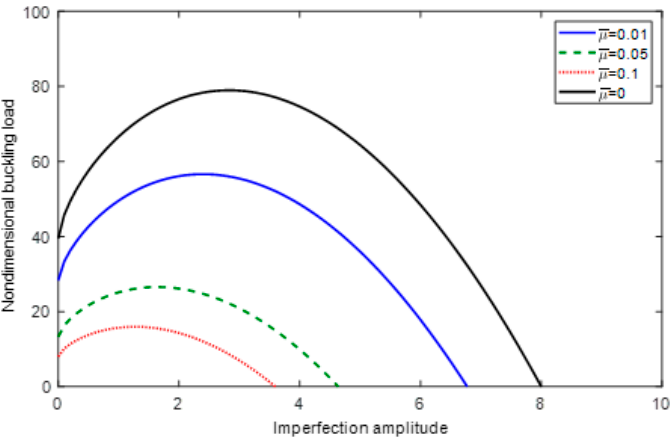
Figure 2. Variation of the buckling load with the imperfection amplitude for 𝛼 =1.